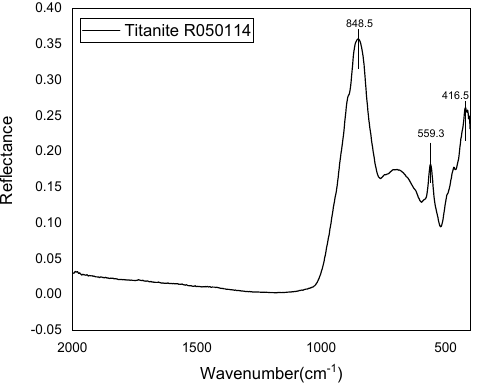
Figure 11. Fourier transform infrared spectrum of titanite R050114 from RRUFF database.